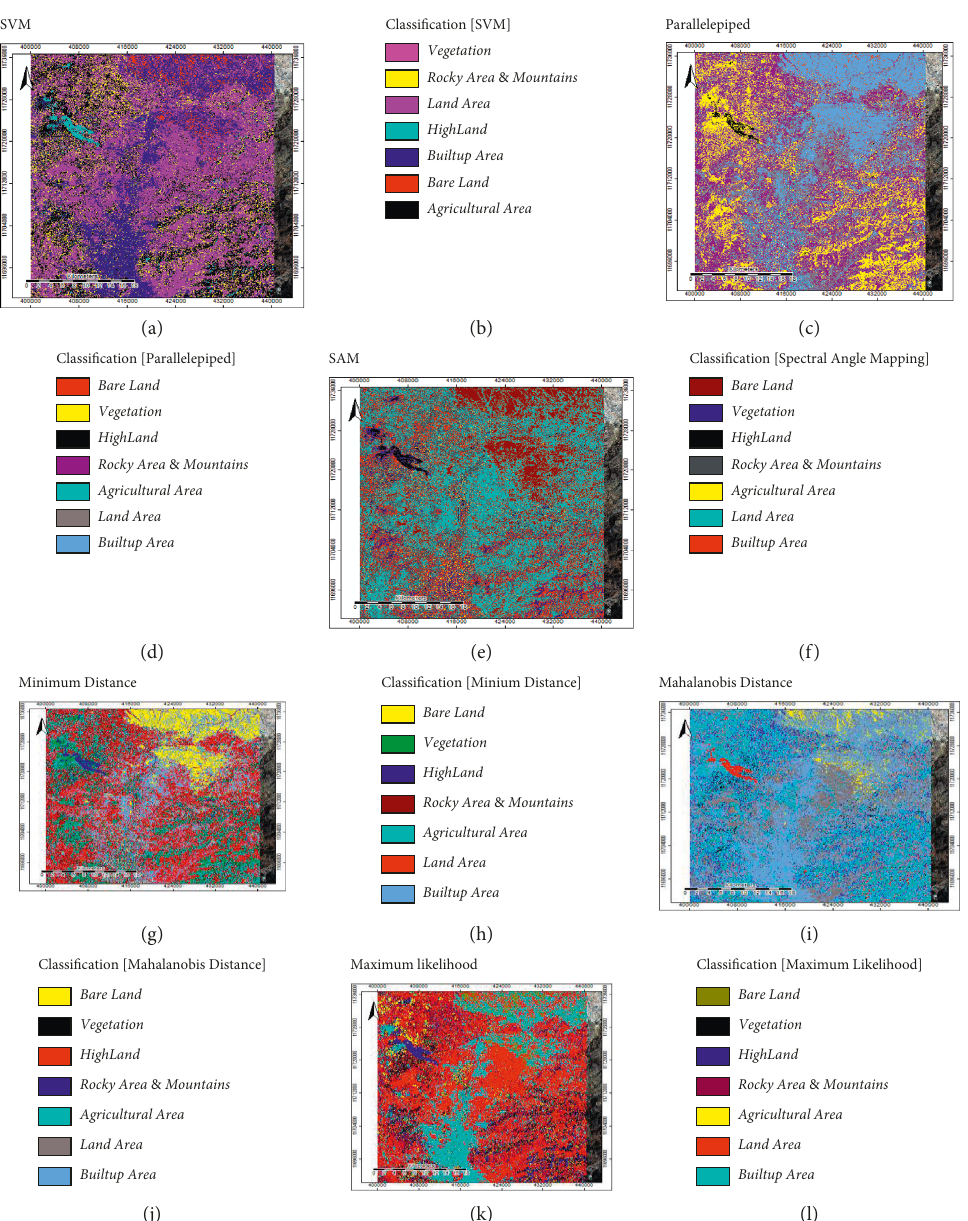
Figure 6: Group 2: land changes classification using machine learning methods with Sentinel-2A. (a, b) SVM classifier. (c, d) Parallelepiped. (e, f) SAM classifier. (g, h) Maximum Distance Classifier. (i, j) Mahalanobis distance classifier. (k, l)